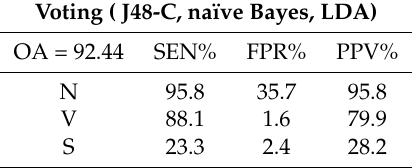
Table 25. Performance measures for combining J48-C, naïve Bayes, LDA classifiers using Voting scheme